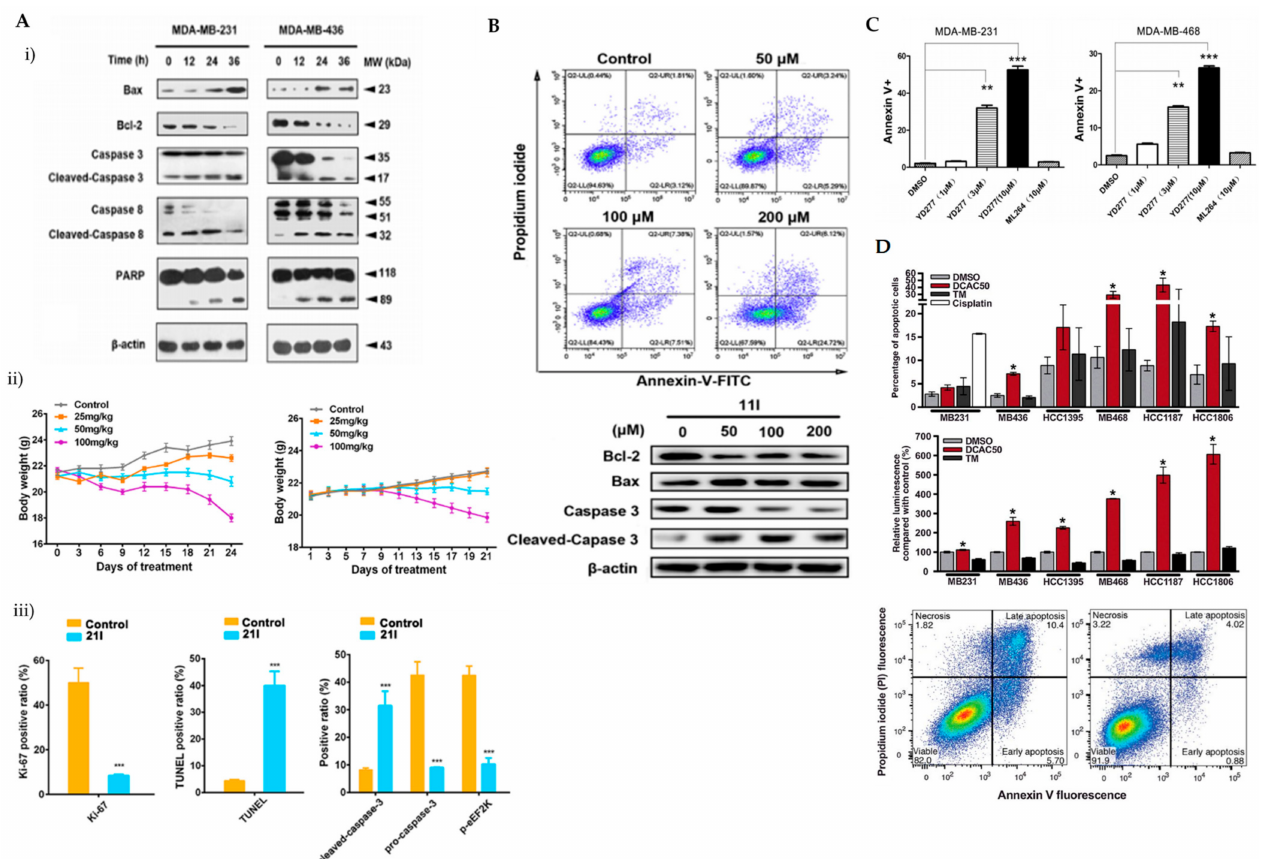
Figure 4. ( A ) ( i ) Western blot analysis of apoptosis-related proteins in MDA-MB-231 and MDA-MB-436 cells treated with